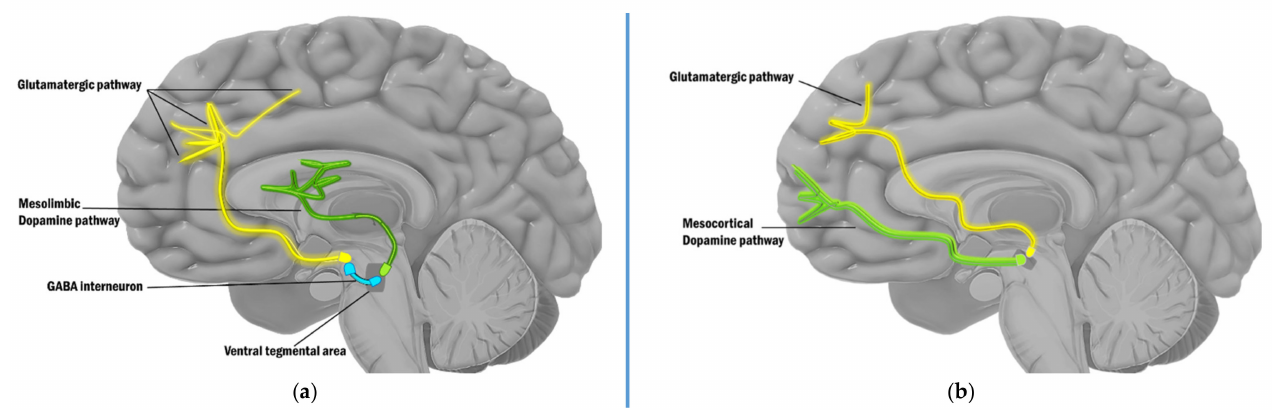
Figure 2. Dopamine pathways’ regulation by the glutamate pathways (green—dopaminergic; yellow—glutamatergic; blue—GABA-ergic): ( a ) Descending glutamatergic pathway connect to the dopaminergic mesolimbic system via a GABA interneuron between them. In the case of disruption, psychotic symptoms emerge; ( b ) The descending glutamatergic pathway exhibits excitatory influence on the mesocortical dopamine pathway, and, in the case of disruption, cognitive deficits